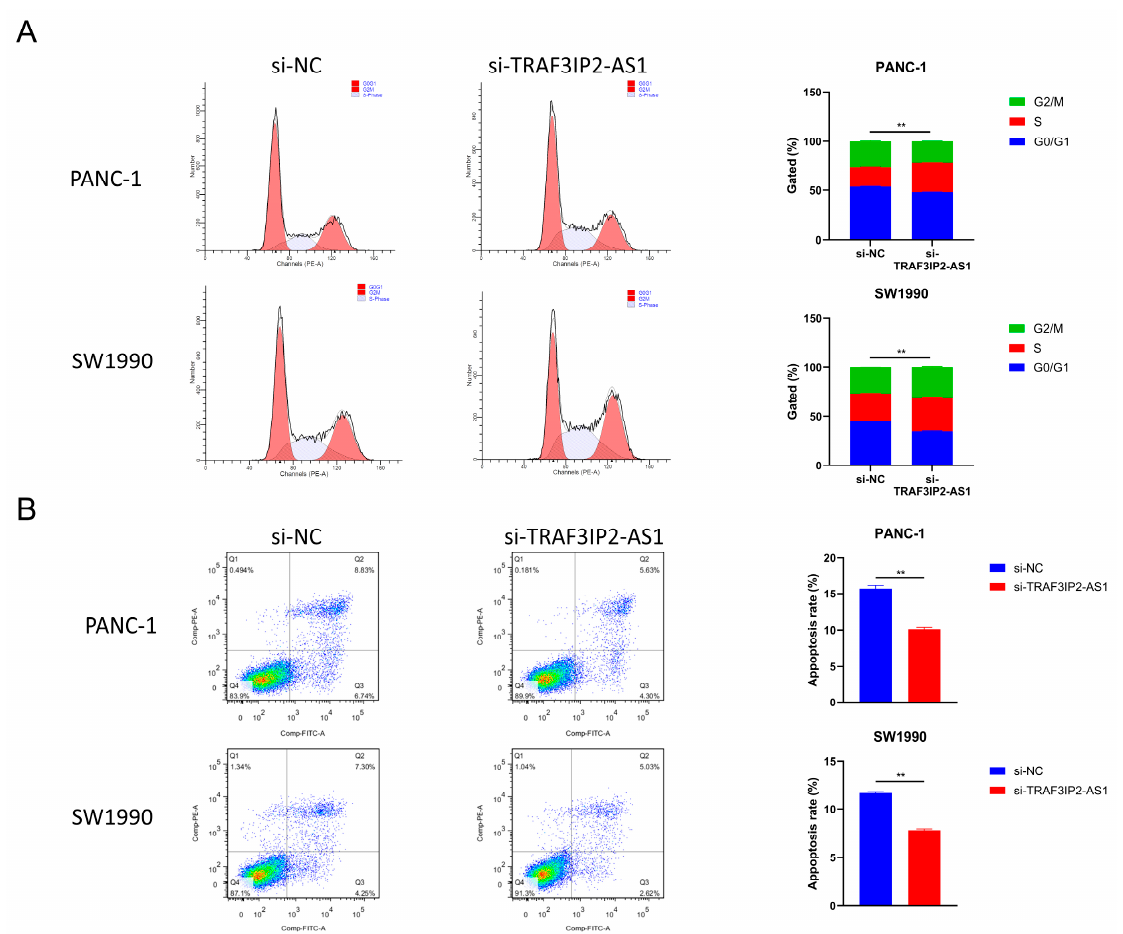
Figure 6. Impact of TRAF3IP2-AS1 knockdown on cell cycle and apoptosis. ( A ) Knockdown of TRAF3IP2-AS1 caused an increase in the S phase during the cell cycle. ( B ) The knockdown of TRAF3IP2-AS1 reduced the apoptosis rate of PDAC cells. The results are presented as quadrant-gated plots. Channel PE stands for propidium iodide; channel FITC stands for fluorescein isothiocyanate. The apoptosis rate exhibited in each bar chart is the sum of cell percentages in sections Q2 (late-phase apoptotic cells) and Q3 (early-phase apoptotic cells). ** p < 0.01.